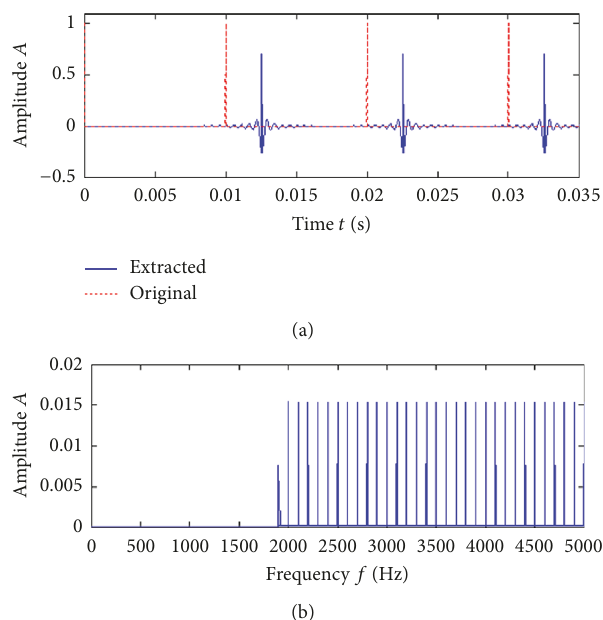
Figure 4: Periodic impacts result of FIR: (a) time domain waveform and (b) FFT spectrum.